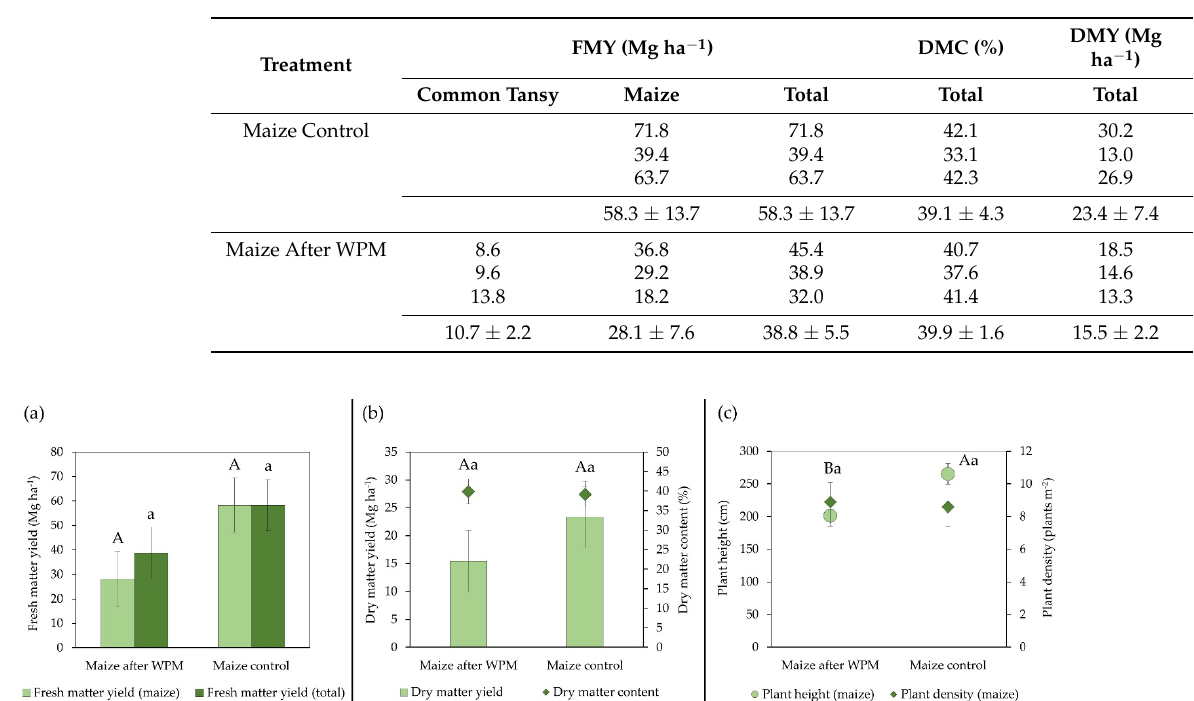
Table 2. The raw data, average values and standard deviations of the fresh matter yields (FMYs) of common tansy and maize and the total biomass (maize + common tansy) per treatment. For the total biomass, the dry matter content (DMC) and dry matter yield (DMY) are also shown.